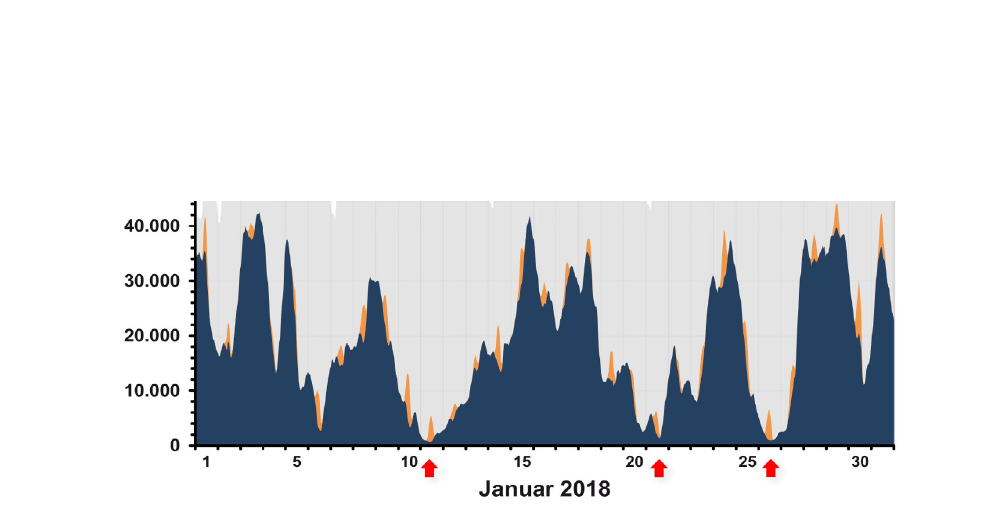
Fig. 2. – Wind (dark area/foreground) and PV (light area/background) electricity production in MW in Germany during January 2018. Note the high correlation of wind and PV power as well as the strong fluctuation and low minimal production in times of no wind/no sun. Figure adapted with friendly permission from